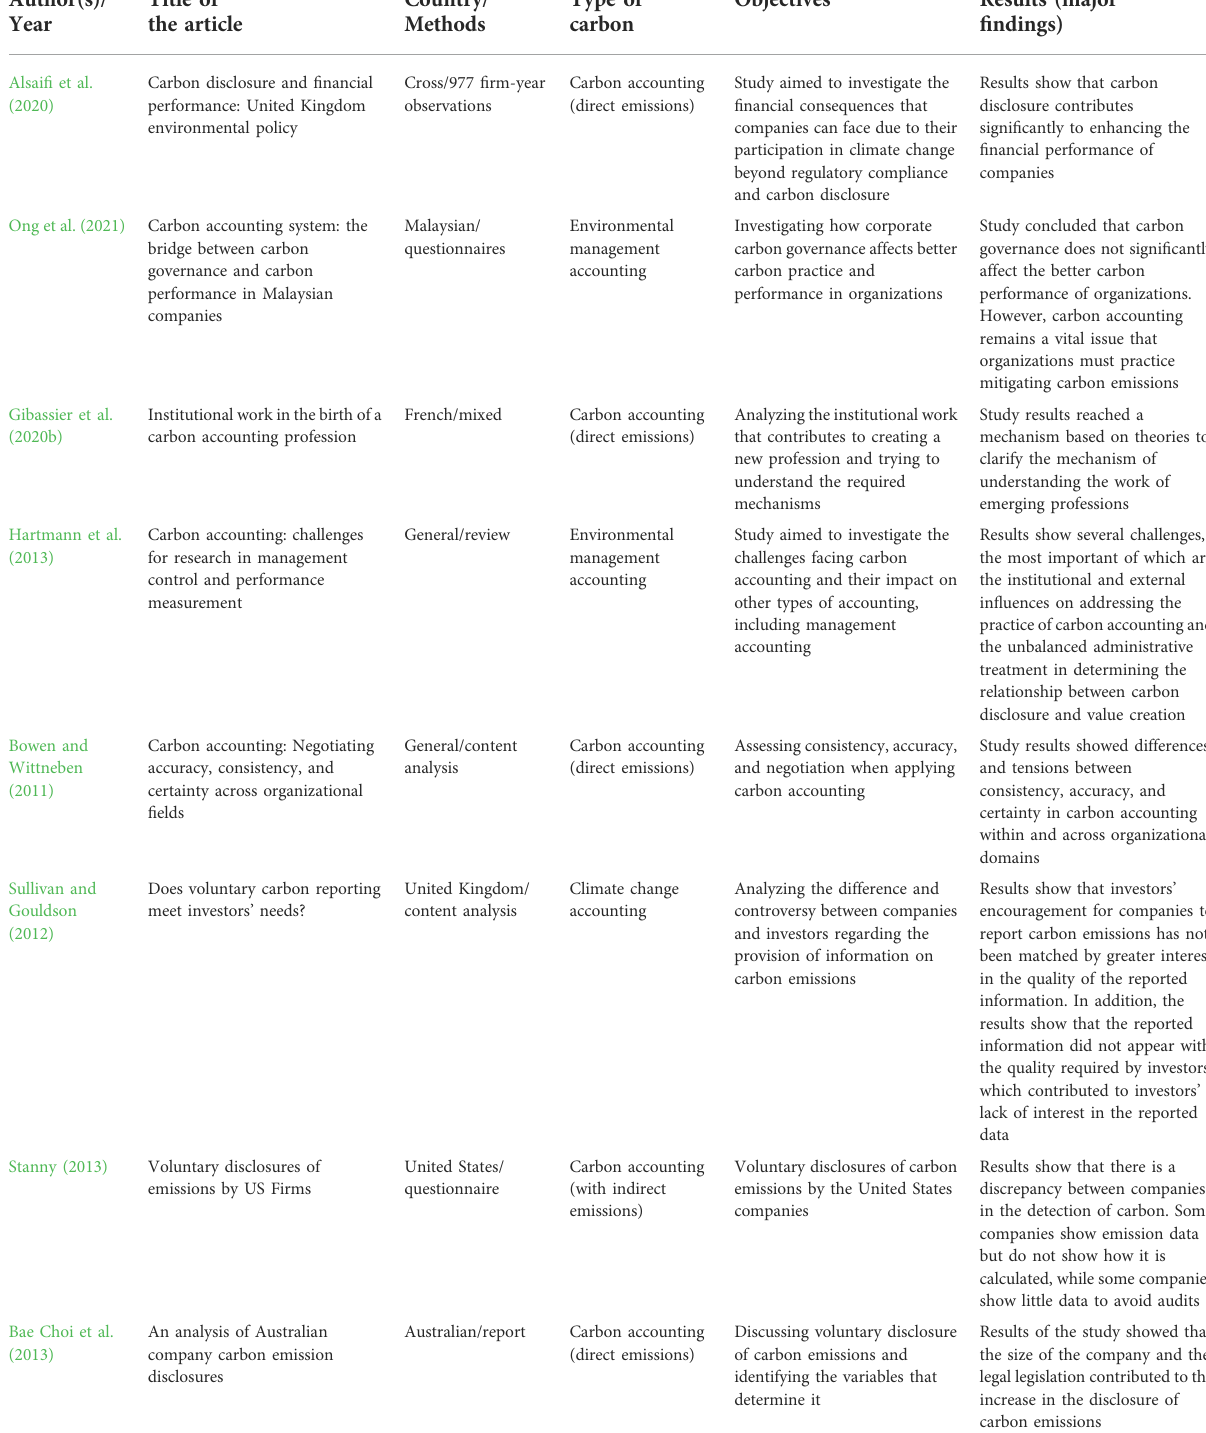
TABLE 5 Summary of the major existing studies regarding organization scale 8 study